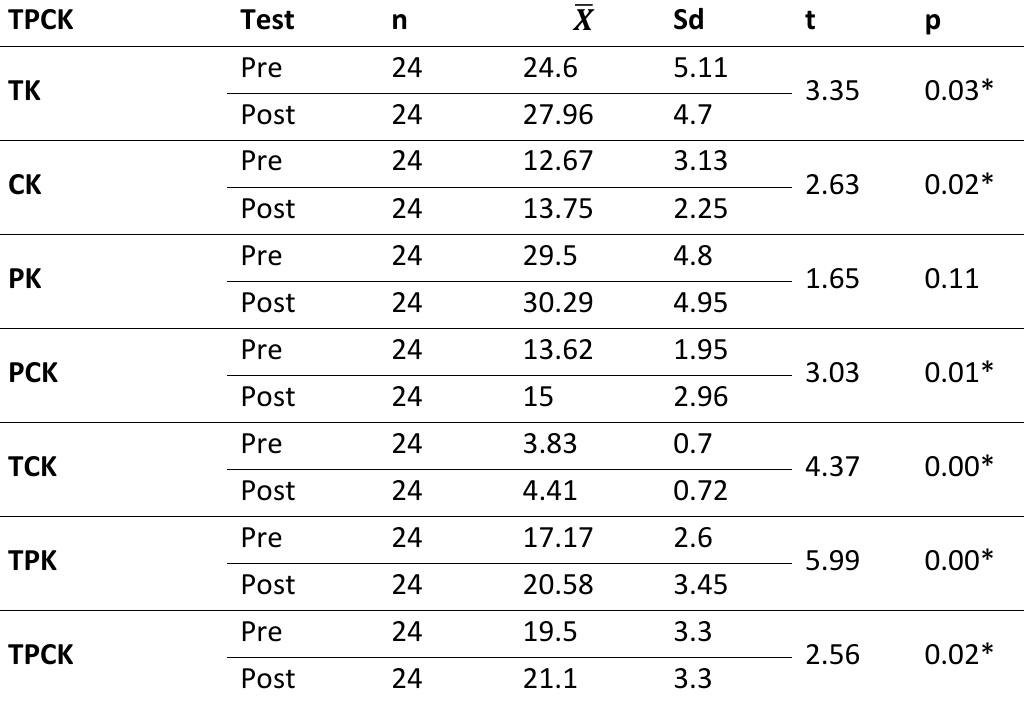
Table 3. Dependent Groups t-test Results for the Teachers' TPCK Pretest and Posttest Scores